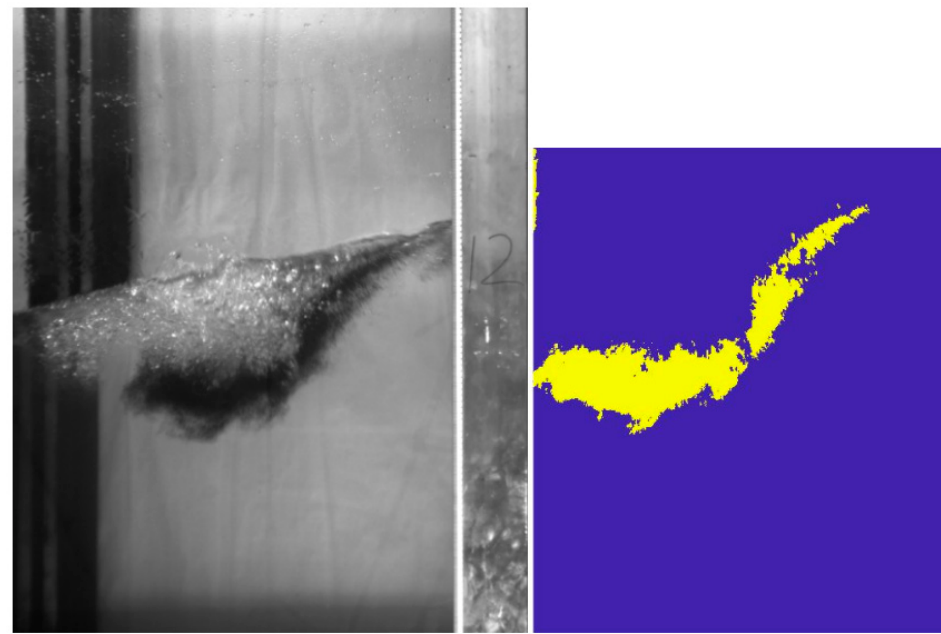
Figure 10. Spilled oil in the observation area was migrated by 25 cm breaking wave.